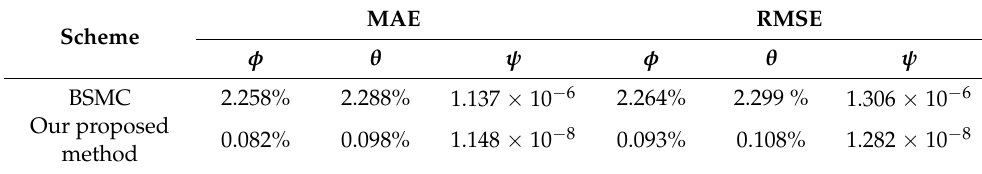
Table 4. MAE and RMSE of angle